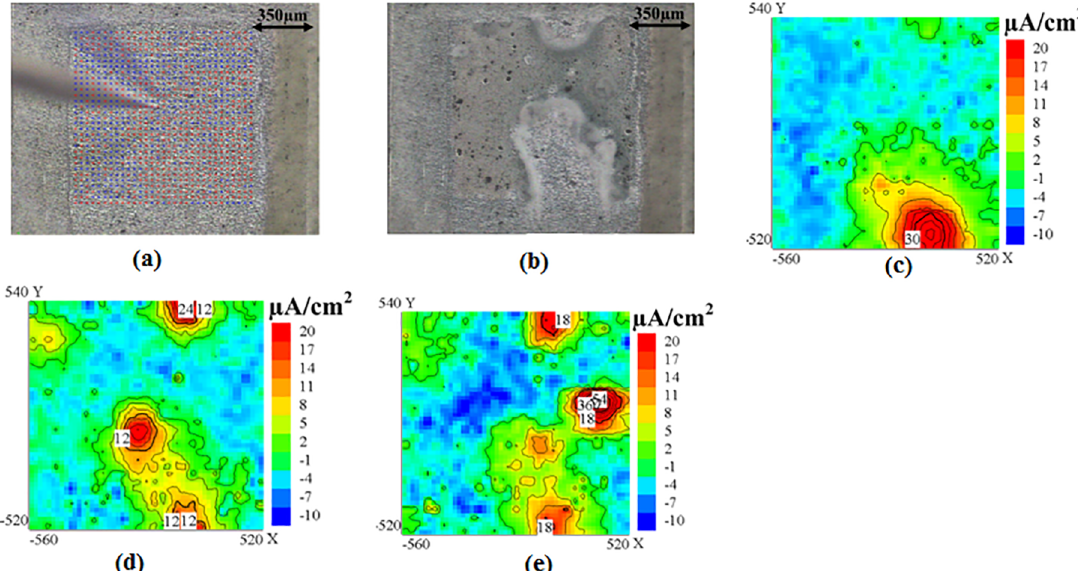
Figure 7. SVET results along 24 h immersion in 0.05 mol L -1 NaCl solution. (a) optical micrograph at the beginning of immersion depicting grid points; (b) optical micrograph after 24h of immersion; (c) , (d) and (e) current density distributions after 1 h, 14 h and 20 h of immersion respectively. X and Y coordinates represent the length of the mapping in